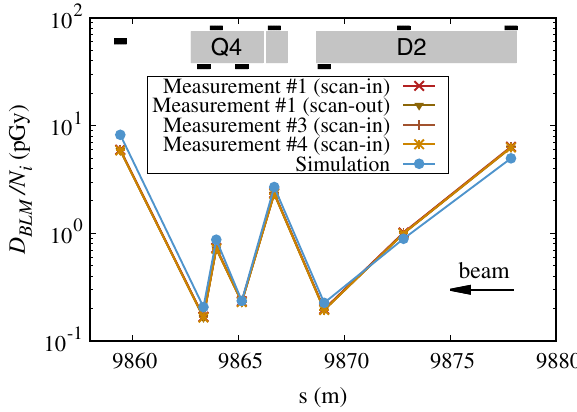
Measurement #1 (scan-in) Measurement #1 (scan-out) Measurement #3 (scan-in) Measurement #4 (scan-in)